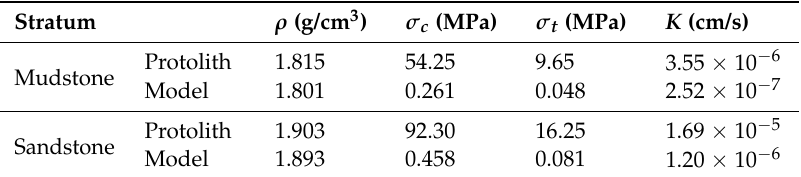
Table 6. The original rock and model parameter of aquifuge.